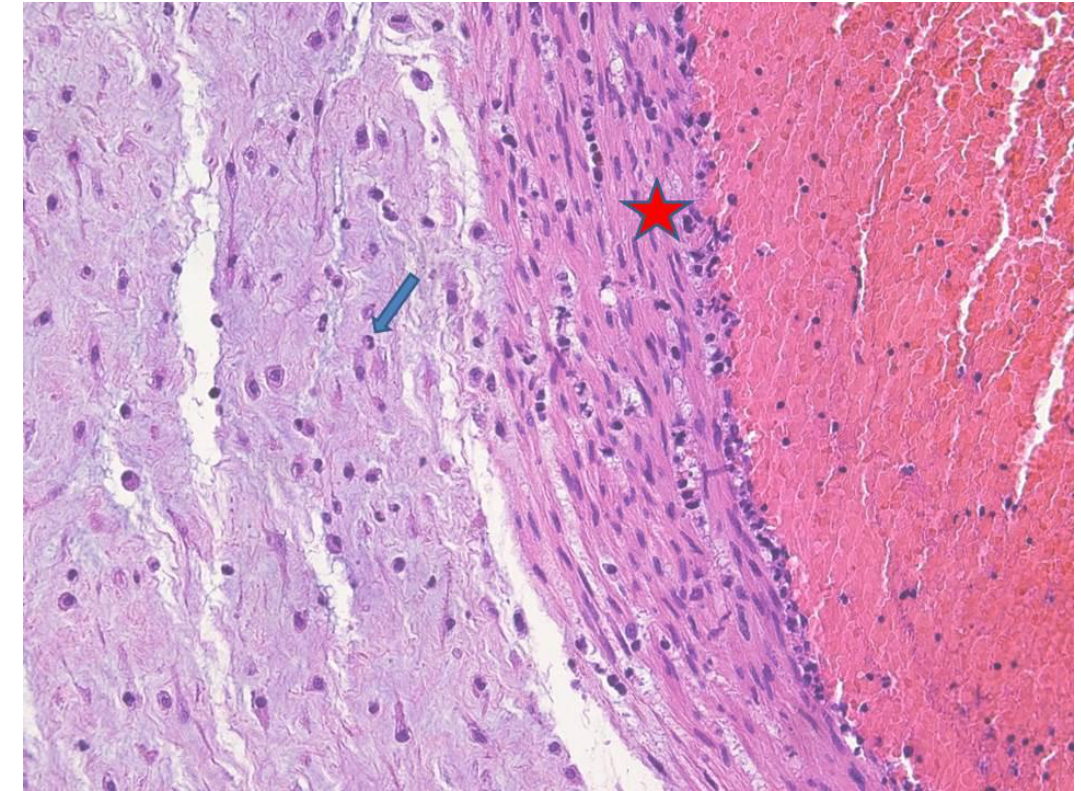
Figure 5. Umbilical vein acute flebitis: the umbilical vein showed acute parietal inflammation (red star) with extension to the Wharton’s jelly (blue arrow) (HE staining 20×).